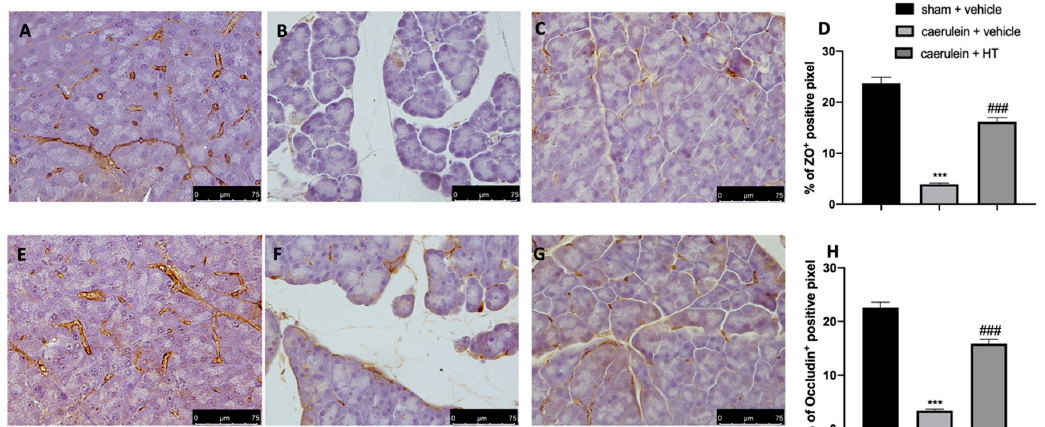
11 of 17 Figure 7. Hydroxytyrosol (HT) effect on intercellular adhesion molecule-1 (ICAM-1) and P-selectin expression: immunohistochemical analysis of ICAM-1 of sham + vehicle ( A ), caerulein + vehicle ( B ) and caerulein + HT (5 mg/kg) ( C ) administration. Graphical quantification of ICAM-1 expression ( D ). Immunohistochemical analysis of P-selectin of sham + vehicle ( E ), caerulein + vehicle ( F ) and caerulein + HT (5 mg/kg) ( G ) administration. Graphical quantification of P-selectin expression ( H ). For the analyses, n = 5 animals from each group were employed. A p - value < 0.05 was considered significant. *** p < 0.001 vs. sham + vehicle, ### p < 0.001 vs. caerulein + vehicle. 3.8. Hydroxytyrosol Preserves the Integrity of the Gut Barrier Loosening of cell–cell adhesion between pancreatic acinar cells and/or endothelial cells increases solute permeability, resulting in interstitial edema, which promotes inflammatory cell migration and disrupts tissue structure [57]. Immunohistochemical analysis of tight junction expression was performed in both pancreas and colon tissue. Tissue collected from vehicle-treated mice showed